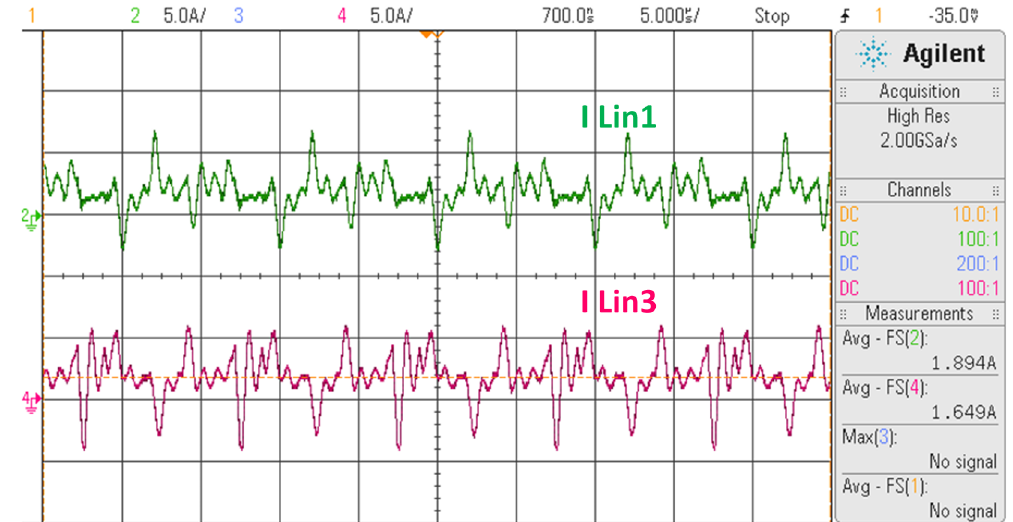
Figure 18. Input inductor currents (Green— I Lin 1 , Violet— I Lin 3 ).